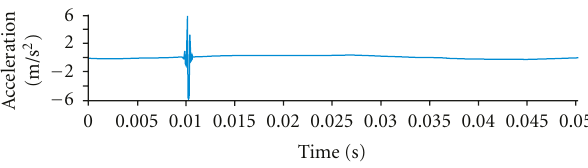
Figure 13: Graph of the parameter β and Renyi Entropy.